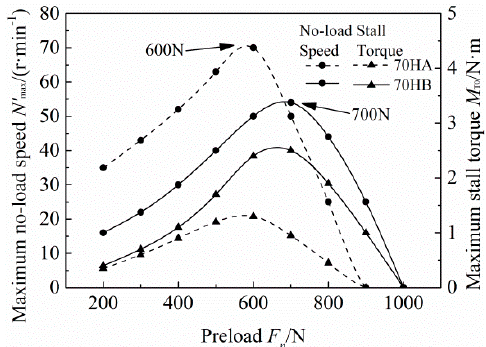
Figure 16. Effect of different preload levels on the mechanical output characteristics of 70HA and 70HB (driving frequency: f 70HA = 51.3 kHz, f 70HB = 25.4 kHz; excitation voltage: U = 440 V pp ).